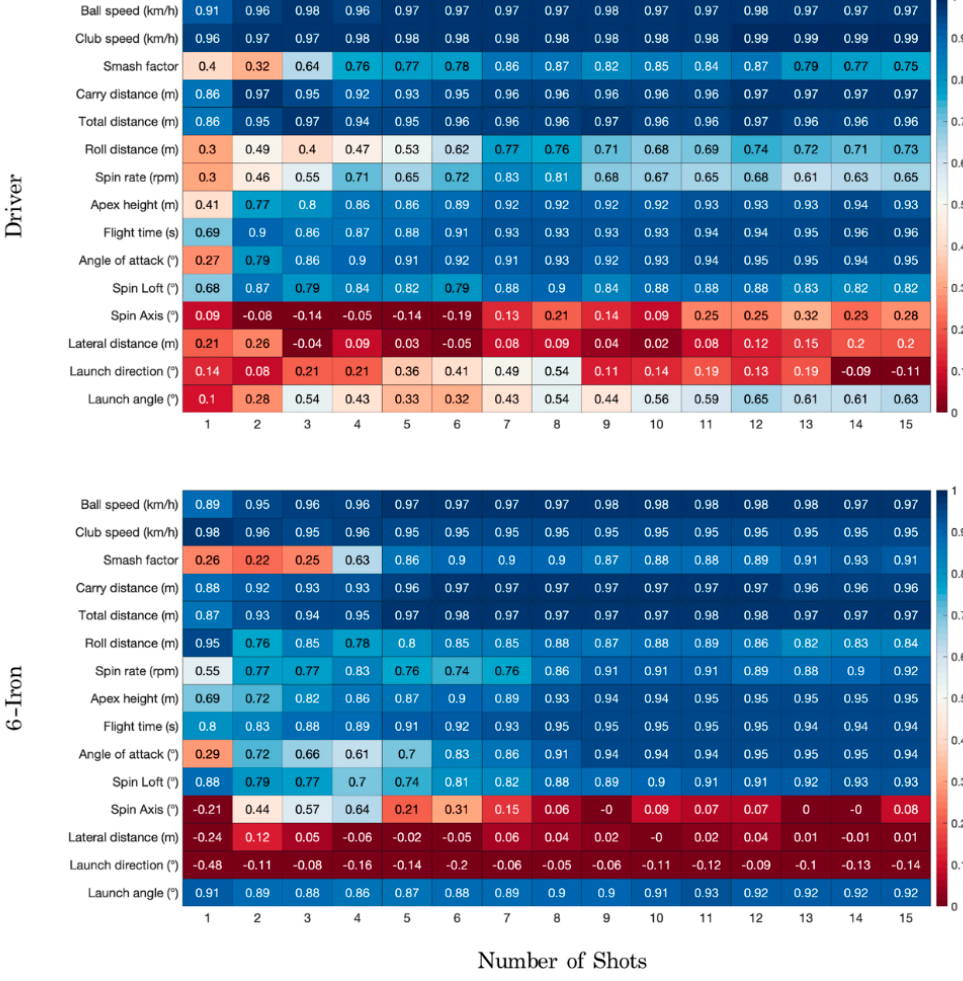
Figure 2. Heatmap representing the ICC values for each golf club and performance parameter using one to fifteen swings. Red colors indicate poor reliability values (below 0.5), while blue tones indicate moderate to excellent reliability values (above 0.5). The number included in each cell represents the ICC value for each performance parameter depending on the number of shots used to compute